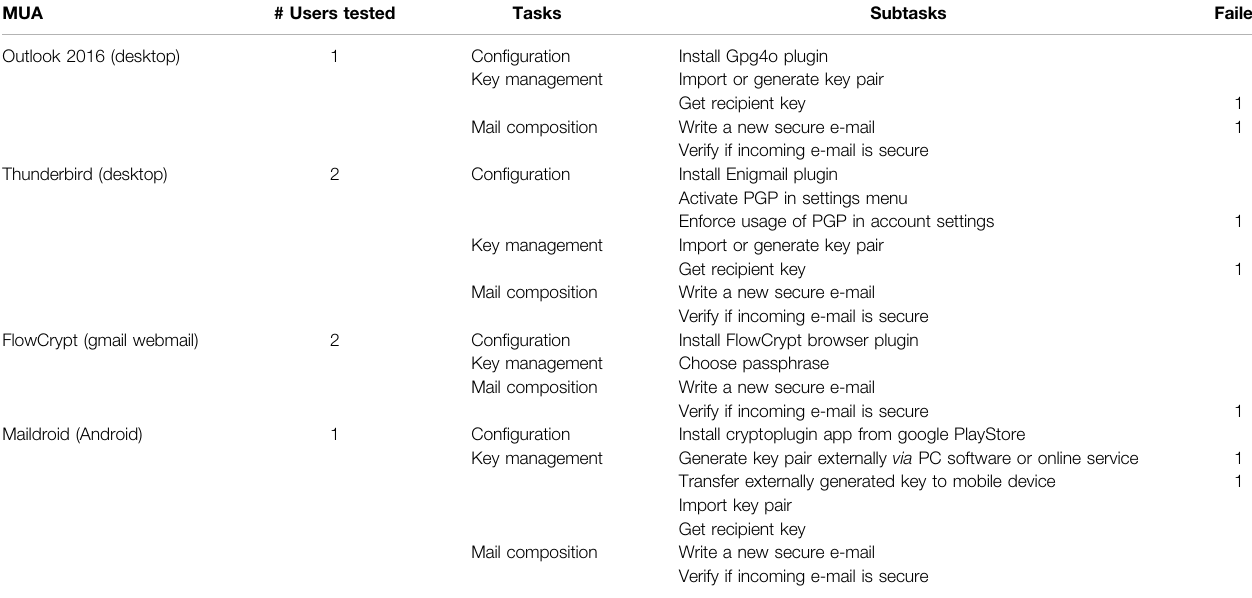
TABLE 6 | User testing results for PGP regarding the number of users who tested an MUA and who failed for a speci fi c sub-task.